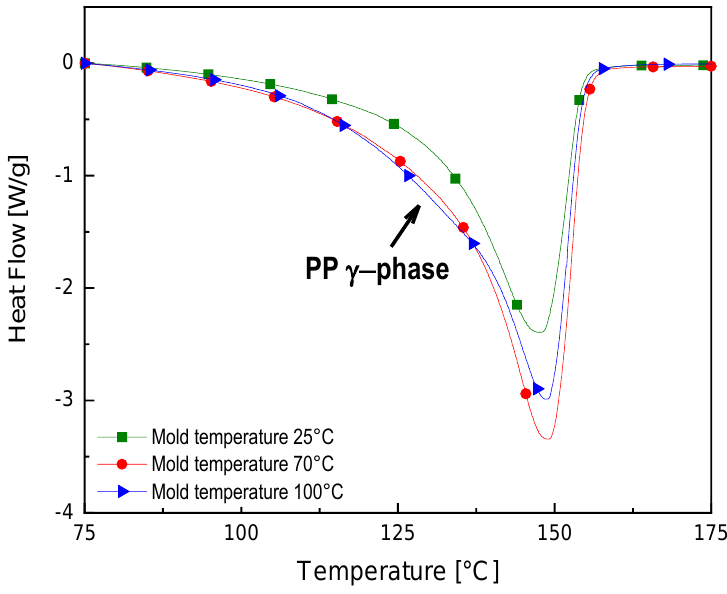
Figure 11. DSC thermogram of 3%-MWCNT nanocomposites manufactured at T25 – 70 – 100 °C (exo up).